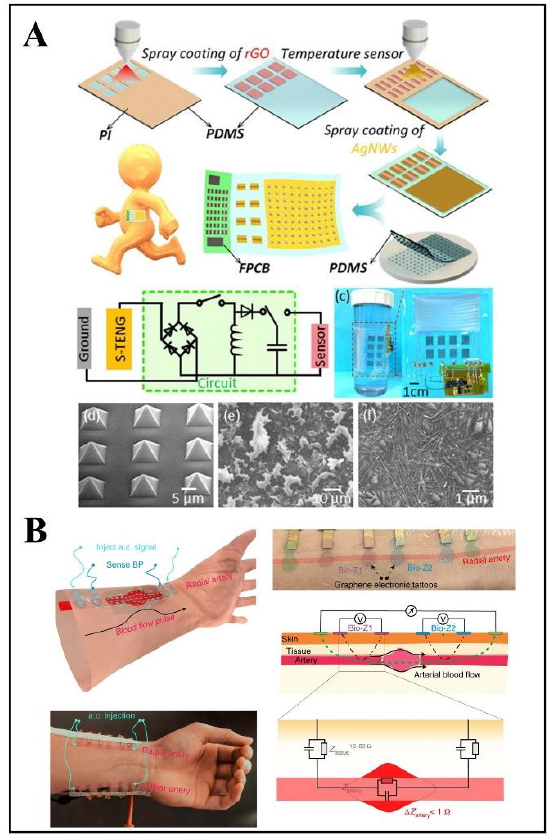
Figure 4. Examples of wearable flexible sensors for temperature and blood pressure monitoring. ( A ) A flexible and transparent smart patch with self-powered for temperature sensing, reprinted with permission from ref. [44]. Copyright 2020, Journal of Applied Physics. ( B ) A flexible blood pressure monitoring device, illustration of Z-BP measurement modality, reprinted with permission from ref.